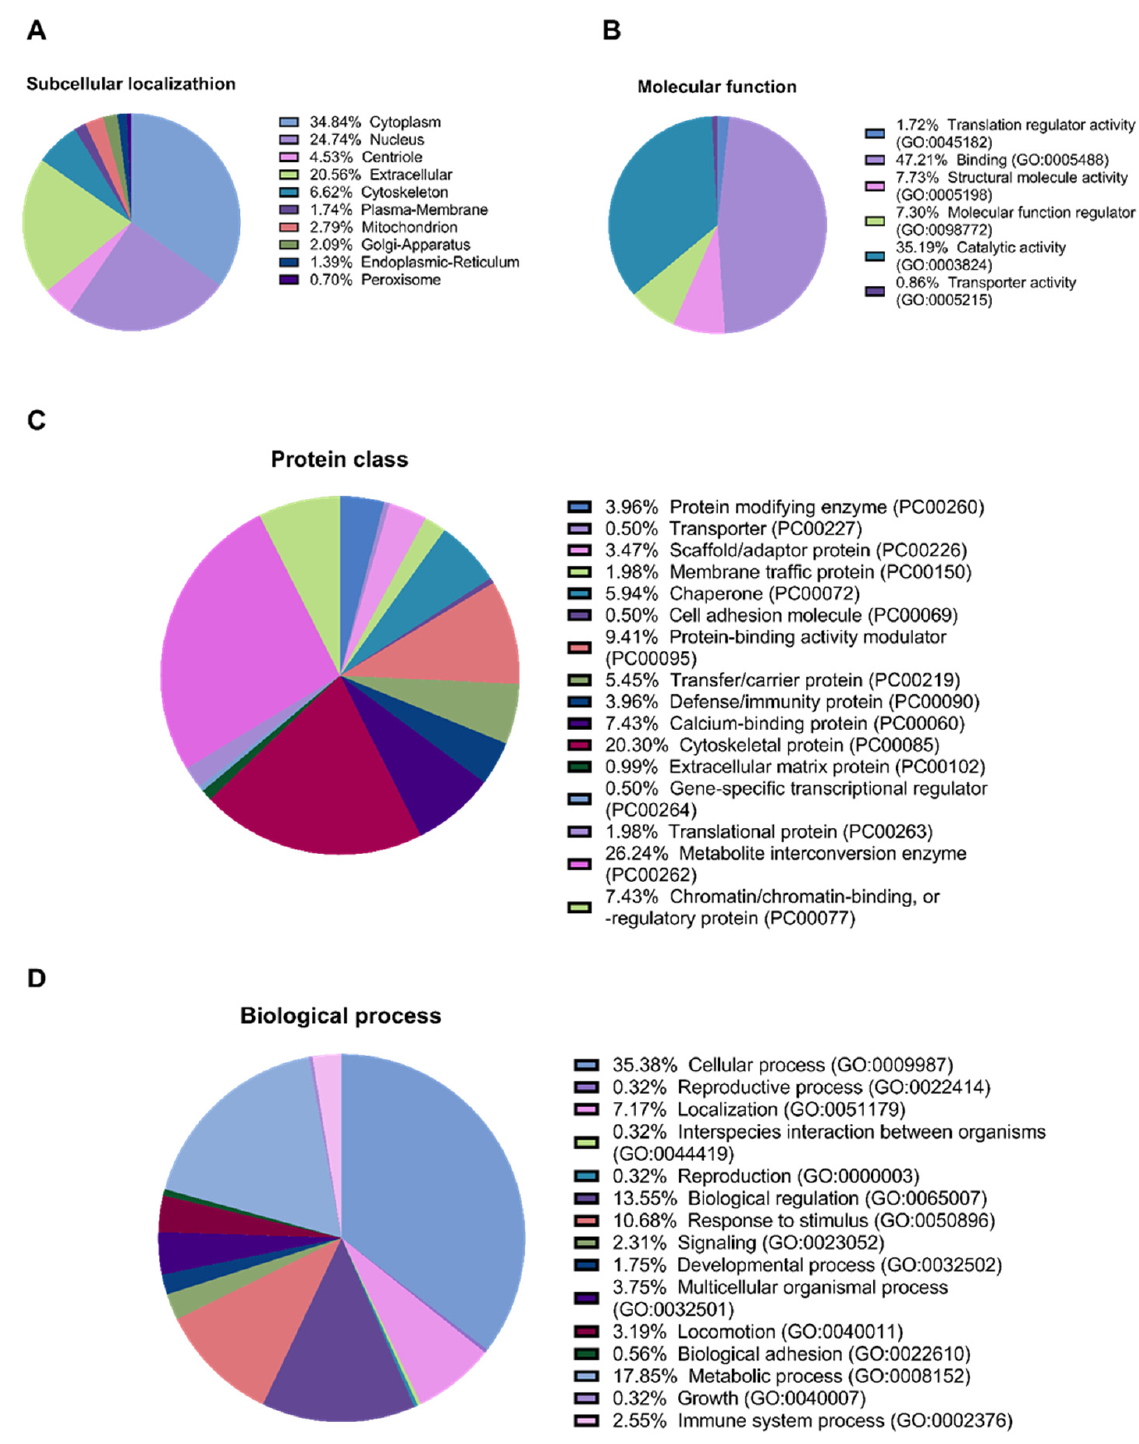
Figure 2. Proteomic analysis of the MMSCs secretome. ( A ) Predictor mGOASVM pie chart of subcellular localisation of proteins identified in the secretome from MMSC cell culture. ( B ) Gene ontology pie chart of molecular functions associated with proteins identified in the secretome from MMSC cell culture. ( C ) Gene ontology pie chart of protein classes associated with proteins identified in the secretome from MMSC cell culture. ( D ) Gene ontology pie chart of biological processes associated with proteins identified in the secretome from MMSC cell culture. MMSC, multipotent mesenchymal stromal cell; mGOASVM, multi-label protein subcellular localisation based on gene ontology and support vector machines.